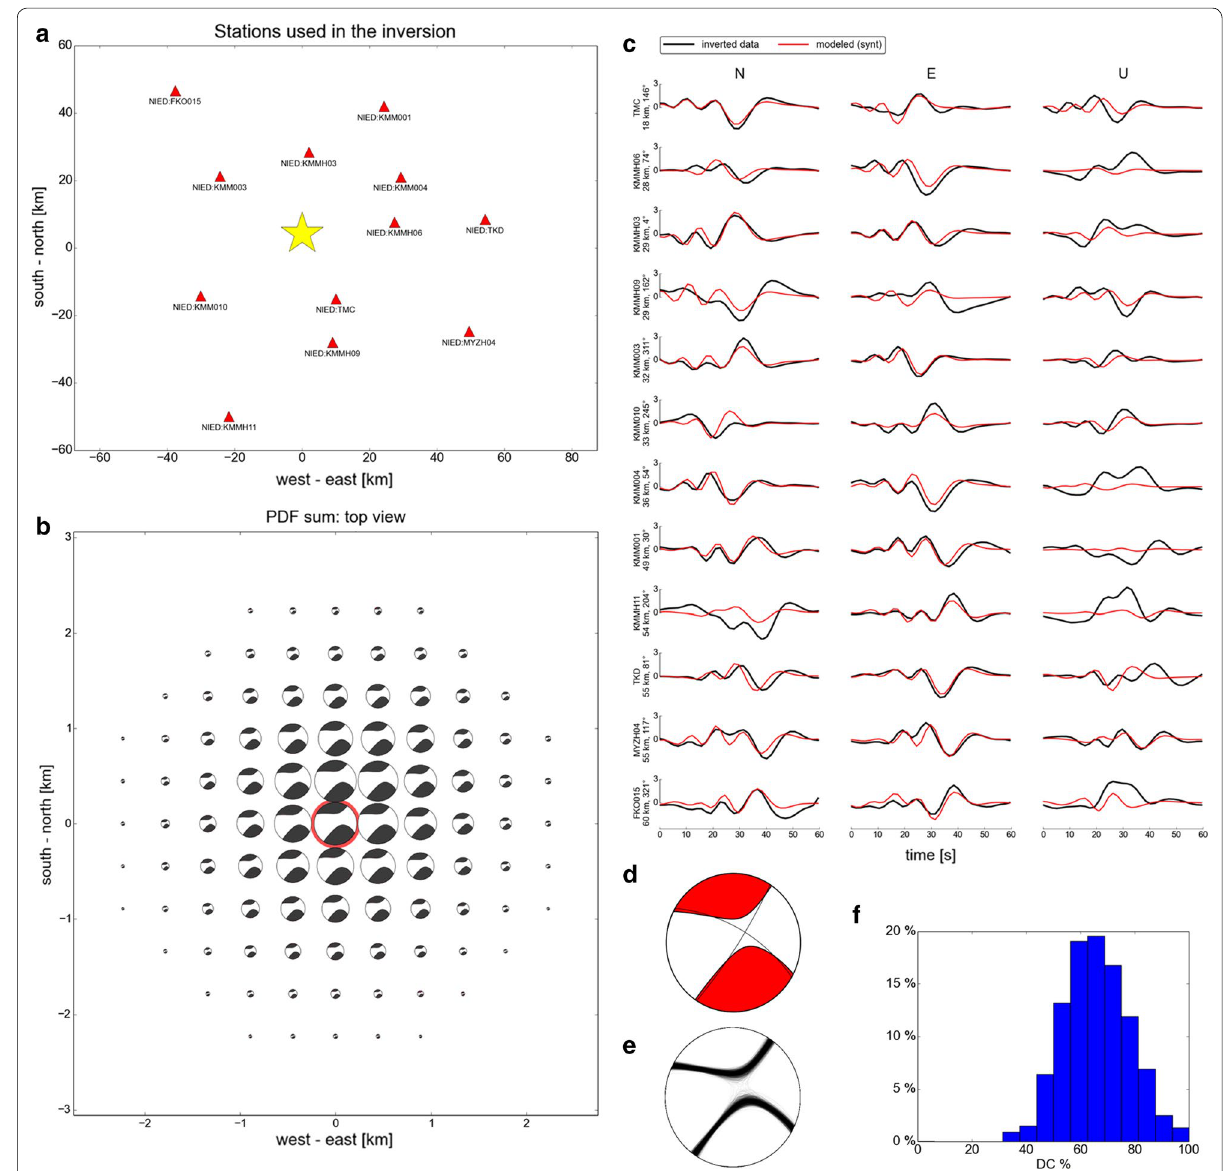
Fig. 3 CMT inversion for the M JMA 6.5 foreshock from 2016/4/14 21:26:35 JST (event No. 1). The figures are produced by modified program ISOLA- ObsPy of Vackář et al. 2017; a the map of strong motion stations (red triangles) used for the CMT inference; b marginal PDF of the CMT location in a horizontal slice indicated by the size of the beach-balls; the beach-balls depict inferred MTs at the individual spatial points. The beach-ball highlighted by red circle is the solution with the highest variance reduction (the best fitting solution); c the comparison between measured and synthetic standardized waveforms for the best fitting solution; d the beach-ball representation of the best fitting CMT; e the uncertainty of the mechanism depicted by 1000 random possible solutions drawn from the ten-dimensional posterior PDF; f histogram of the DC